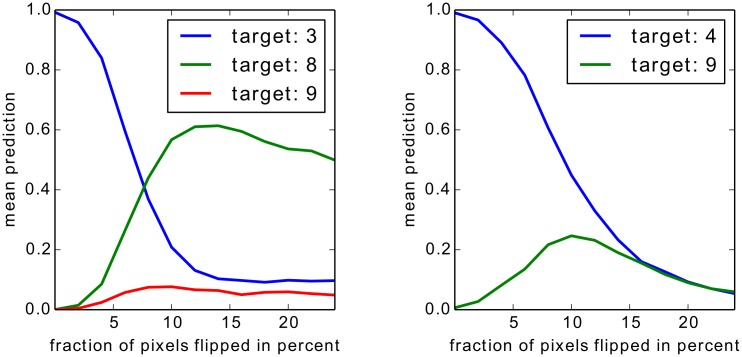
Flipping of high-scoring non-digit pixels.Pixels with highest positive scores are flipped first. The pixel-wise decomposition was computed for the true digit class, three (left) and four (right).